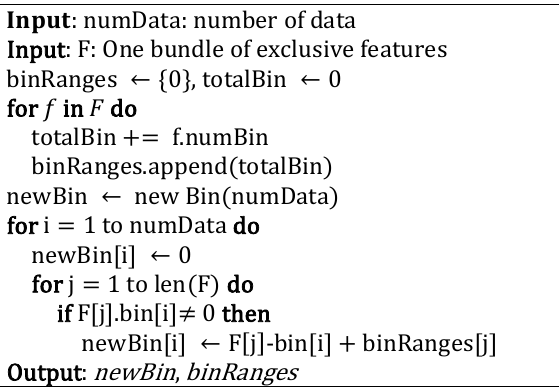
Table 1. Data feature